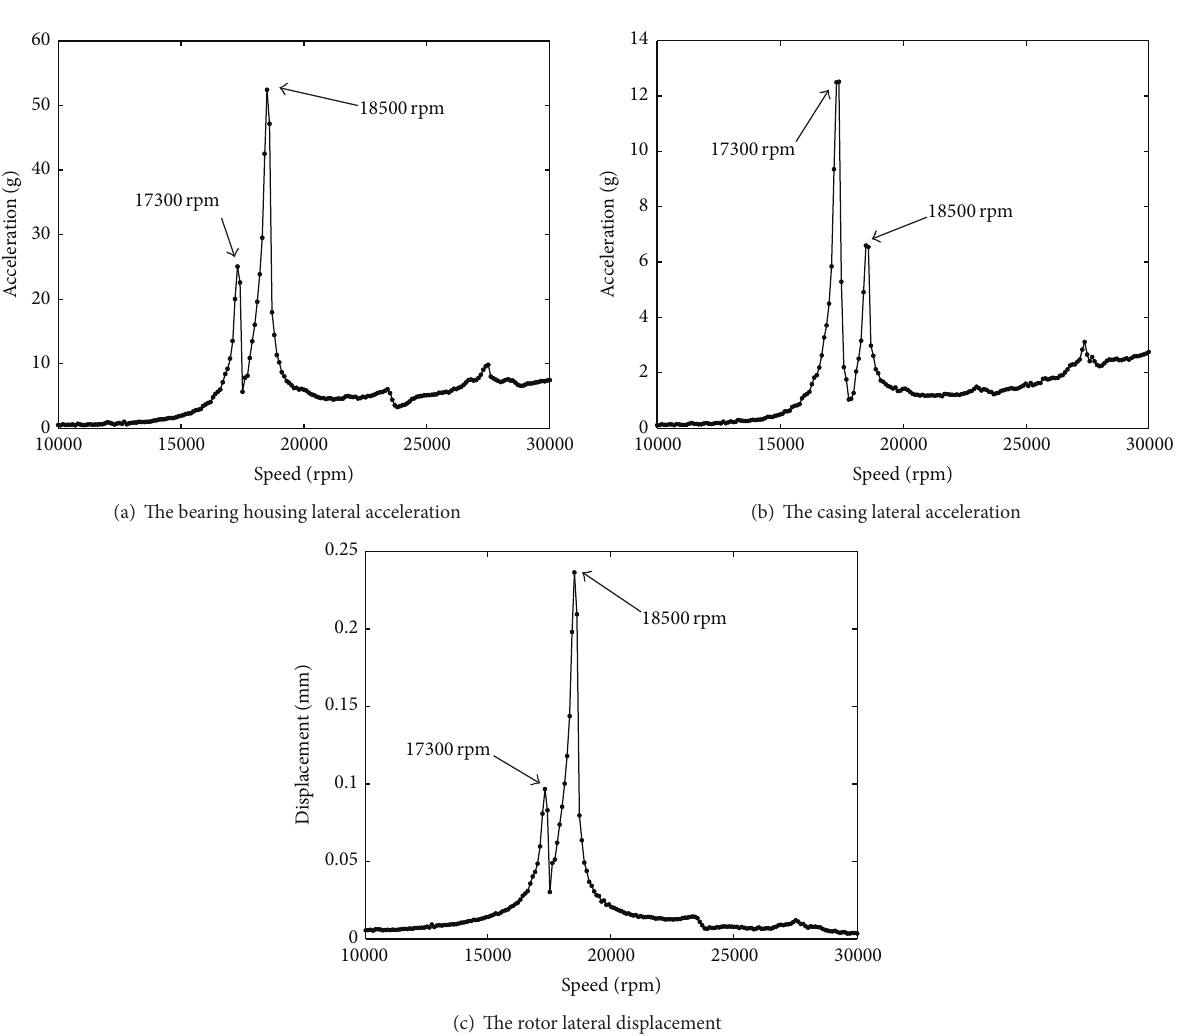
Figure 5: Amplitude-speed curves of bearing, casing lateral acceleration, and rotor displacement (without looseness).